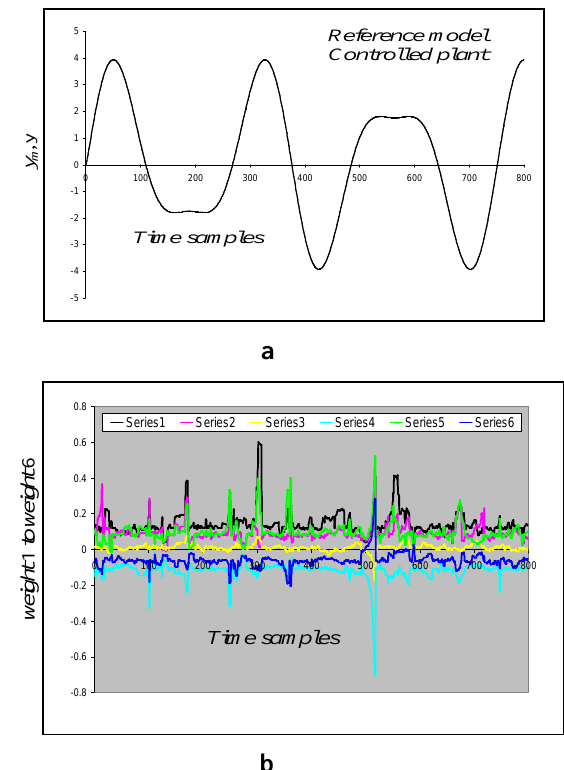
Fig. 3. Plant 1 (a) outputs of the reference model and the controlled plant (b) on-line adaptation of the six weights in the SRWNN